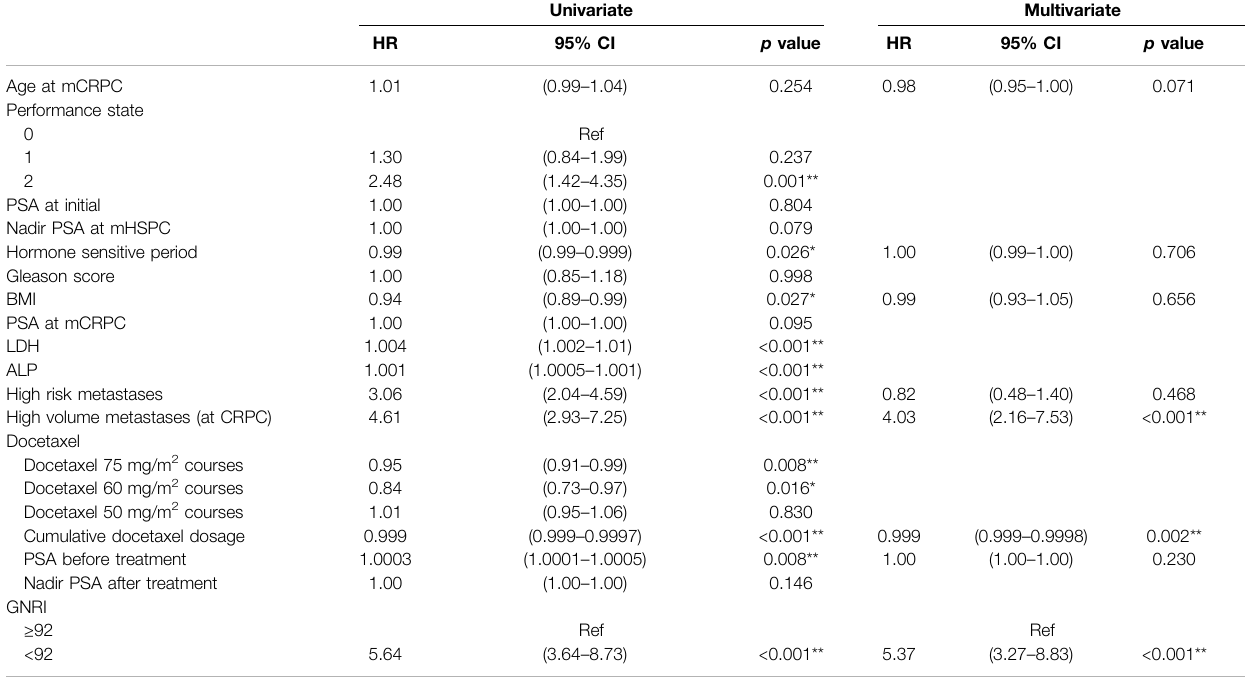
TABLE 2 | Uni-Multi variant analysis for overall